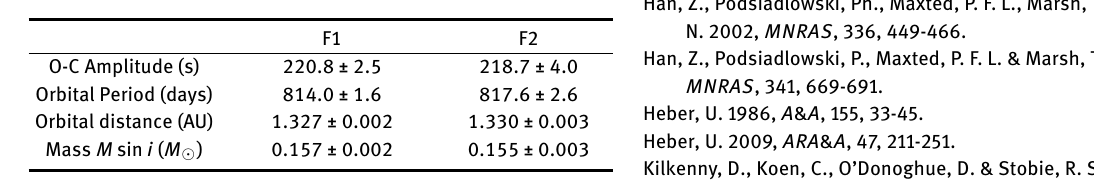
Table 3. O-C diagrams best fit results for F1 and F2